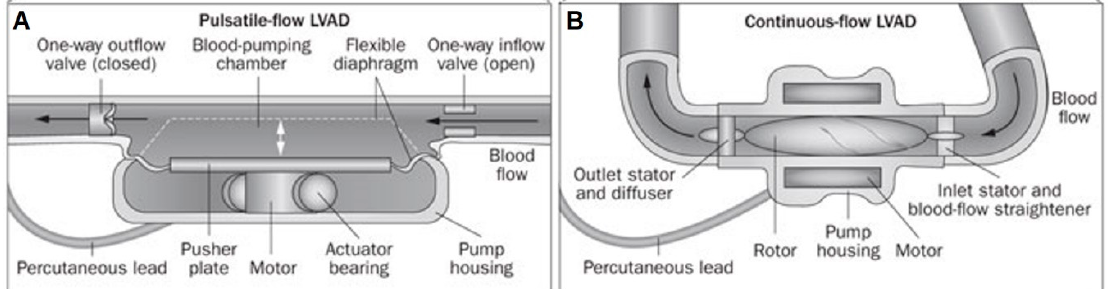
Figure 1. The first generation pulsatile-flow pumps ( A ) replicated the native cardiac cycle using a diaphragm and unidirectional artificial heart valves, while the second generation continuous-flow pumps ( B ) integrated a valveless axial pump designed to rapidly spin a single impeller.